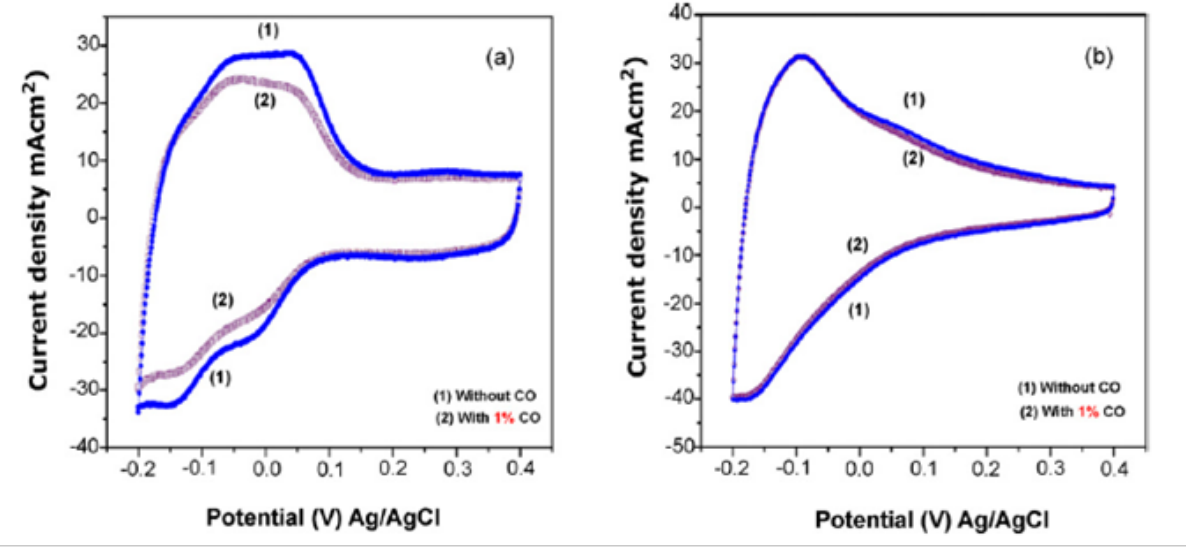
Figure 5. CO tolerance test of (a) 20wt% Pt/C (E-Tek), (b) 7.5wt% Pt/WC (Reprinted from Reference 79 with